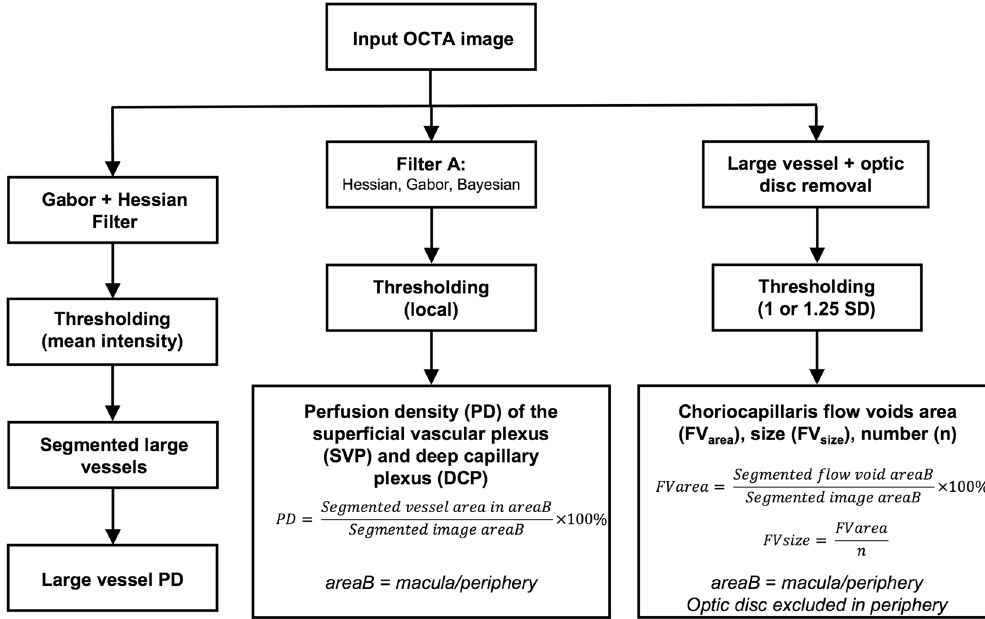
Figure 6. Flowchart of post-imaging processing to obtain perfusion densities of the (1) large vessels, (2) superficial and deep capillary plexuses as well as (3) choriocapillaris flow void area, number, and